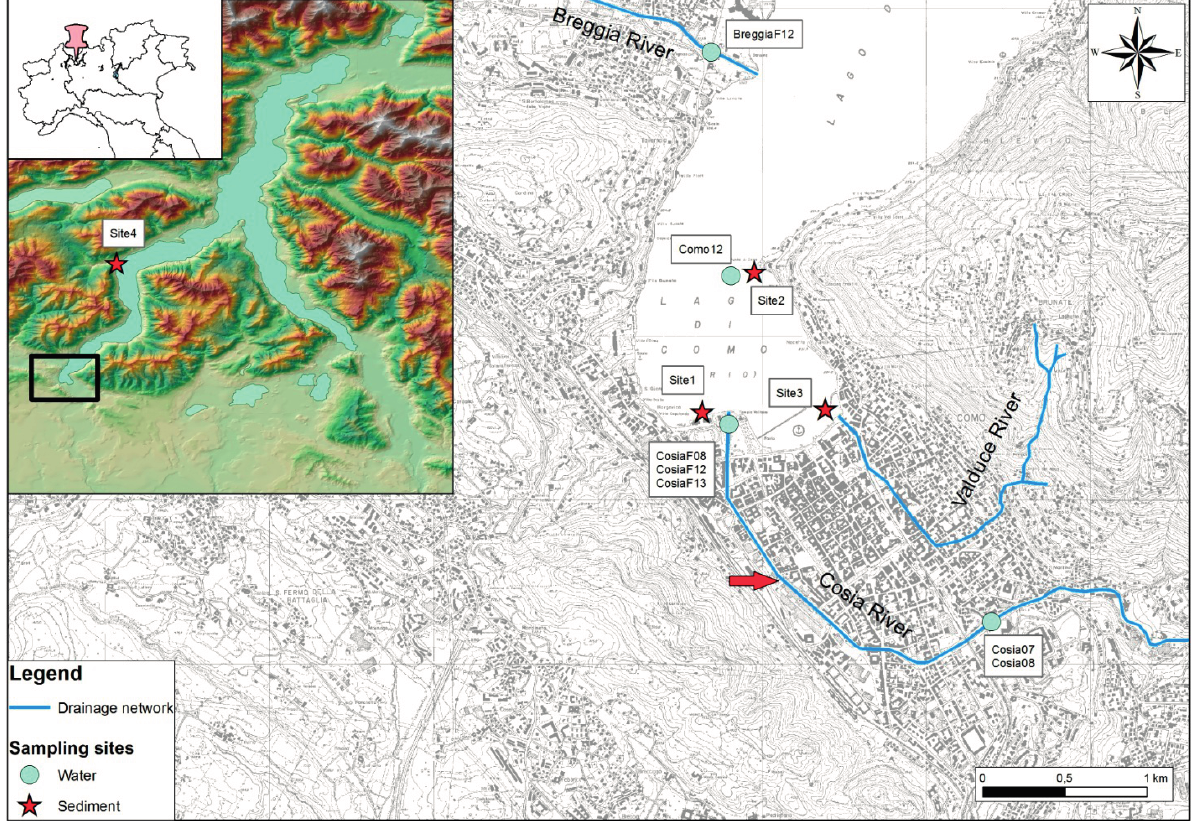
Figure 1. Map of Lake Como with sample sites. The bullets show different water sample points with the sampling year. Stars show sediment sample sites. The arrow indicates the inflow of the wastewater treatment plan into the Cosia